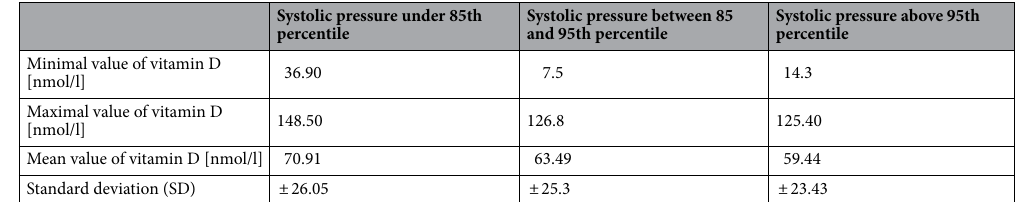
Systolic pressure between 85 and 95th percentile